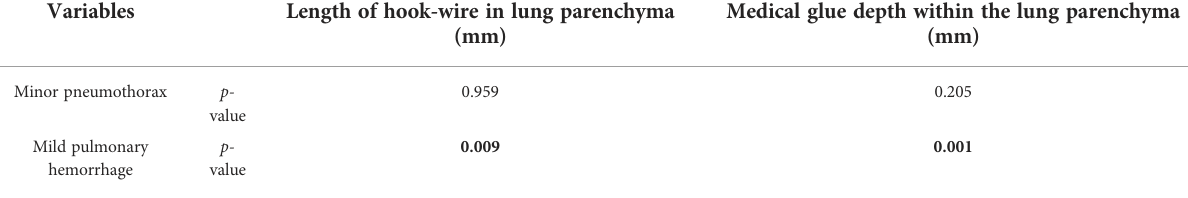
TABLE 2 Results of Spearman correlation